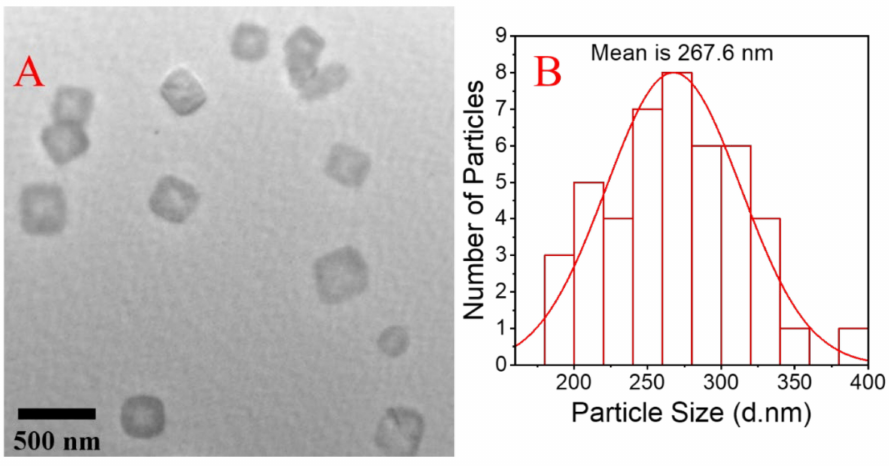
Figure 5. ( A ) TEM image of the prepared sample and ( B ) histogram of the notable microstruc- tures’